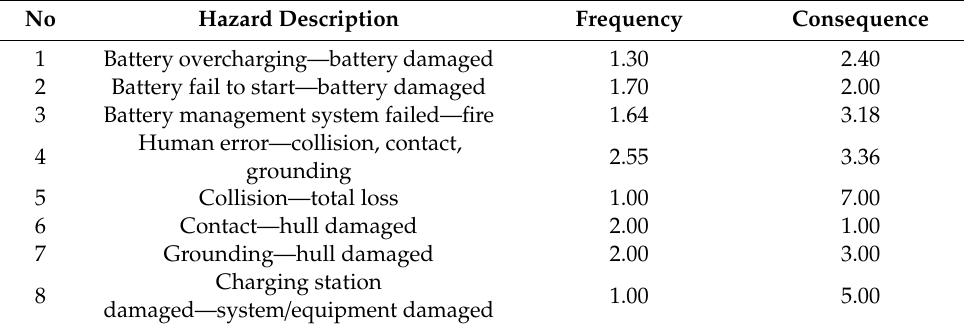
Table 7. HAZID questionnaire results—operation: arrive and leave port.